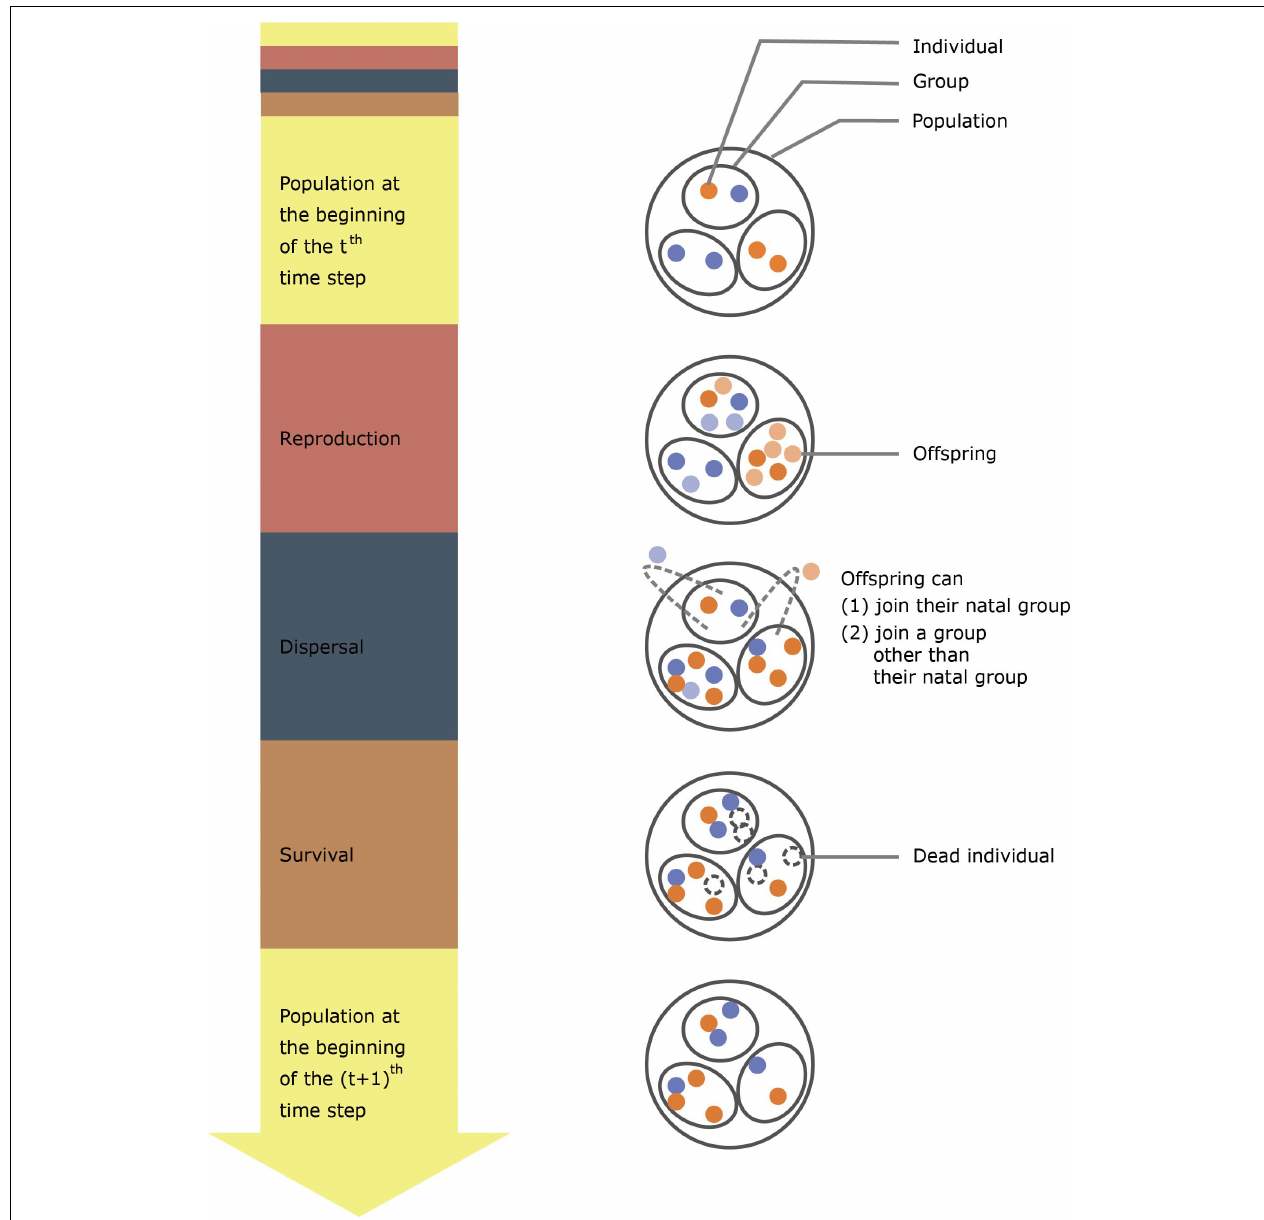
FIGURE 1 | A schematic diagram for the model. The diagram shows the process that a population undergoes within one simulation time step. The red, blue, and brown portions in the arrow on the left represent reproduction, dispersal, and survival stages in an individual lifecycle, respectively. Orange and blue dots represent cooperators and non-cooperators, respectively, lighter colors represent newborn individuals, and dashed circles represent dead